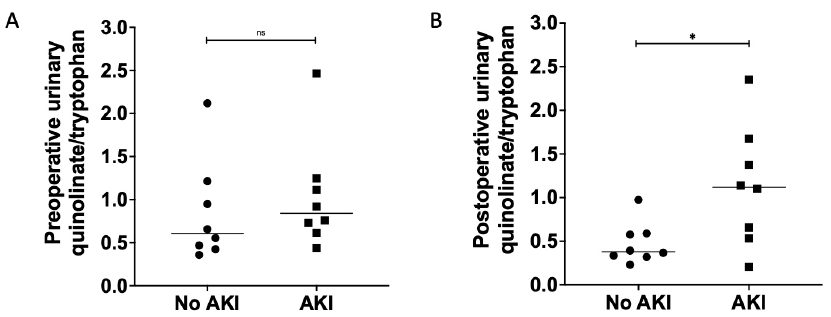
Figure 2. Urinary quinolinate/tryptophan ratio for patients with and without postoperative AKI: ( A ) preoperative quinolinate/tryptophan ratio and ( B ) postoperative quinolinate/tryptophan ratio. ns denotes non-signi fi cant di ff erence, * denotes p < 0.05. 3.4. Association between Quinolinate and Postoperative Creatinine The mean 48 h postoperative serum creatinine change from baseline was 0.71 mg/dL (0.27, 1.86) in patients that developed postoperative AKI and − 0.13 mg/dL ( − 0.26, 0.04) in patients that did not develop postoperative AKI. The postoperative quinolinate/tryptophan ratio was positively correlated with the 24 h postoperative increase in serum creatinine from baseline (R = 0.58, p = 0.02) and with the 48 h postoperative increase in serum creatinine from baseline (R = 0.60, p = 0.02). After adjusting for age, sex, preoperative eGFR, and diabetes using principal component analysis, higher preoperative urine quinolinate concentrations were associated with higher 48 h maximum serum creatinine changes from baseline after surgery ( p = 0.04, Figure 3). Additionally, higher urinary quinolinate to tryptophan ratios measured on the morning of postoperative day one were associated with higher 48 h maxi- mum serum creatinine changes from baseline after surgery ( p = 0.04, Figure 4).